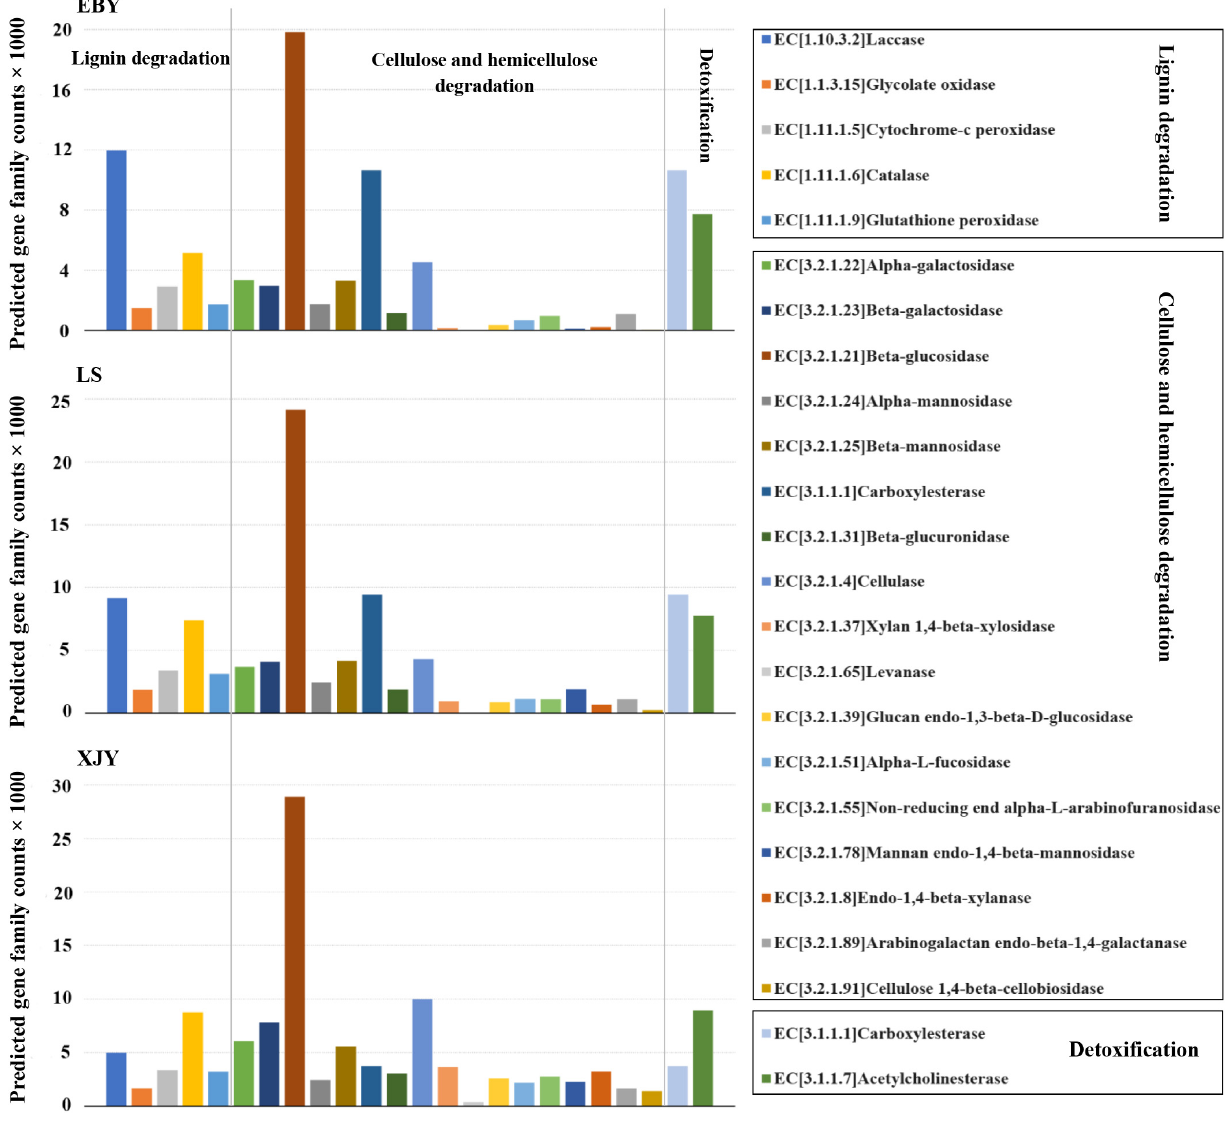
FIGURE 8 | Predicted fungal community functions in the A. glabripennis larval gut following feeding on different host tree species. The total number of predicted gene family counts is shown. EBY, Populus gansuensis ; LS, Salix babylonica ; XJY, Populus alba var. pyramidalis